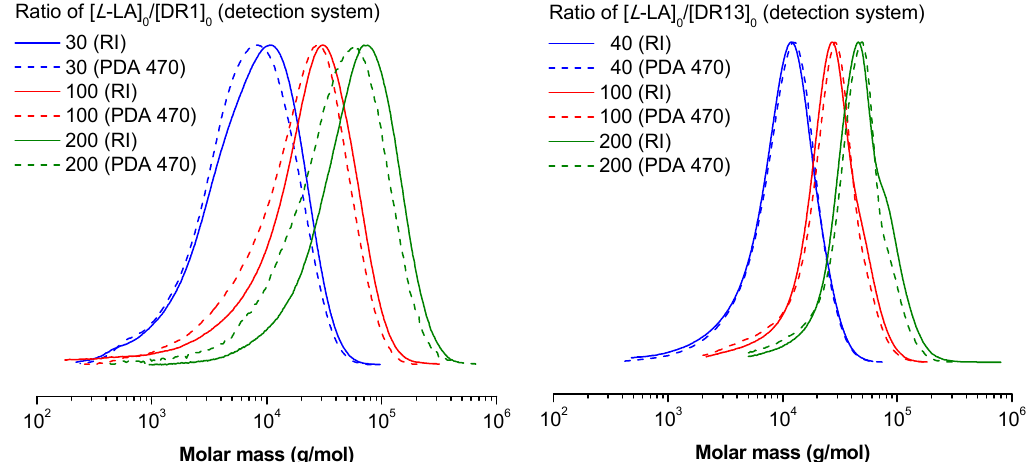
Figure 8. Gel-permeation chromatography (GPC) traces for selected PLA-n-DR obtained from various detection systems: refractometer (solid lines) and photo diode array (PDA) detector at 470 nm (dashed lines) for various ratios of [ L -LA] 0 /[ROH] 0 for polymerization initiated with DR1 (left plot) or DR13 (right plot) series.